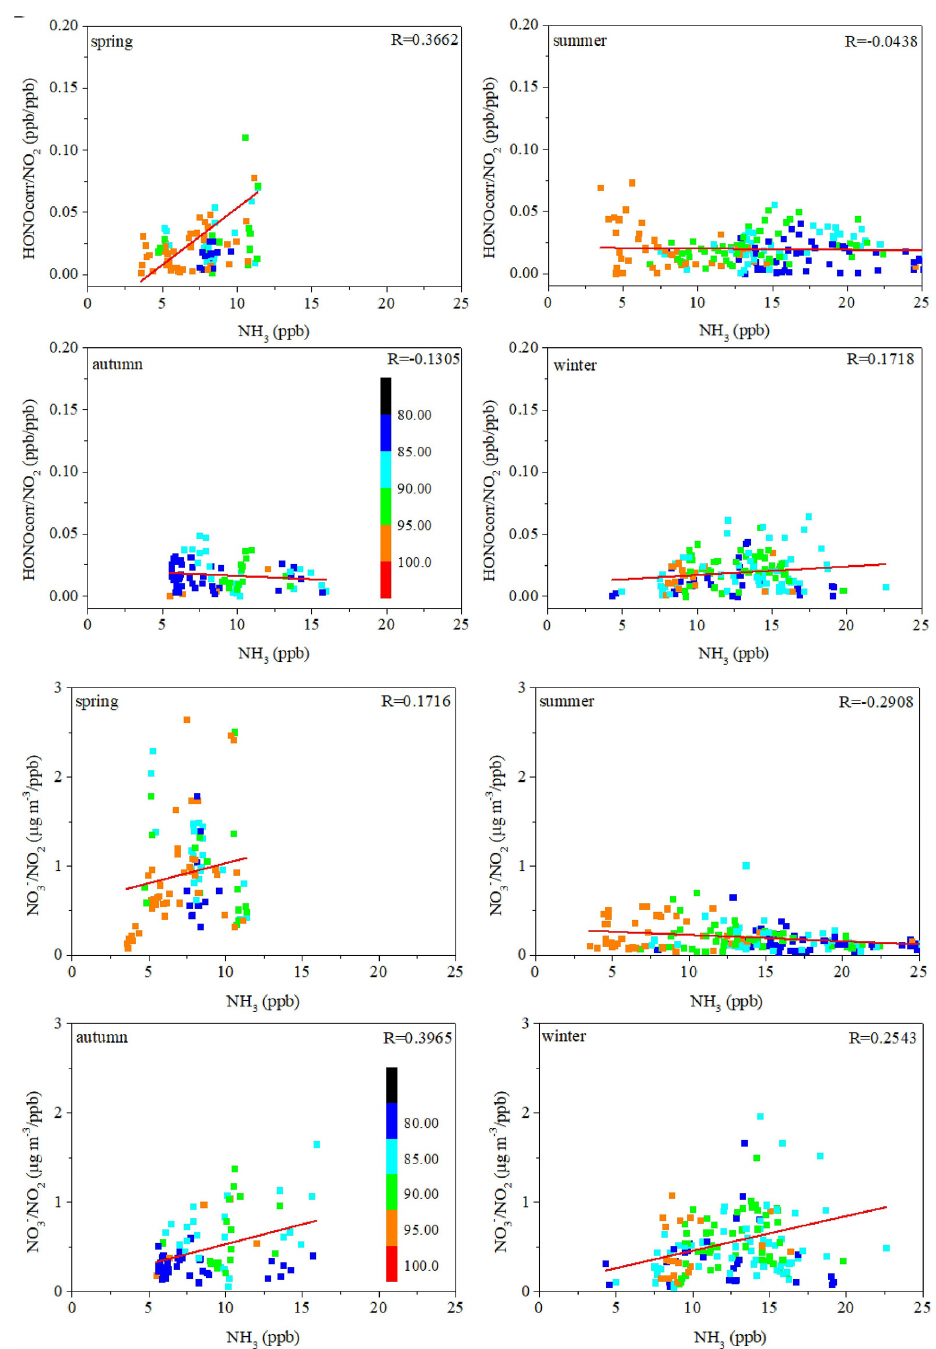
Figure 6. The correlation between the NH 3 concentration and HONO / NO 2 ratio (upper) and the correlation between the NH 3 concentration / NO 2 (lower) in four seasons. The scatter points were colored by ambient RH values. and NO − 3